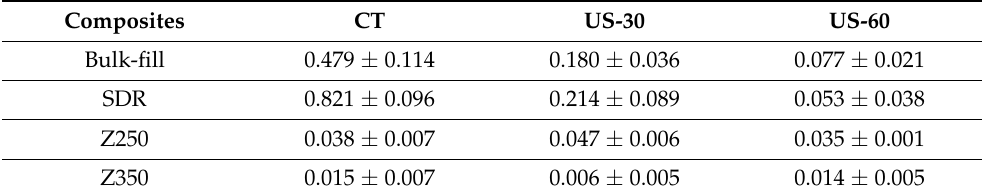
Table 2. Mean (SD) void volume (mm 3 ) of composite groups without (CT) and with ultrasonic application of 30 s (US-30) and 60 s (US-60).